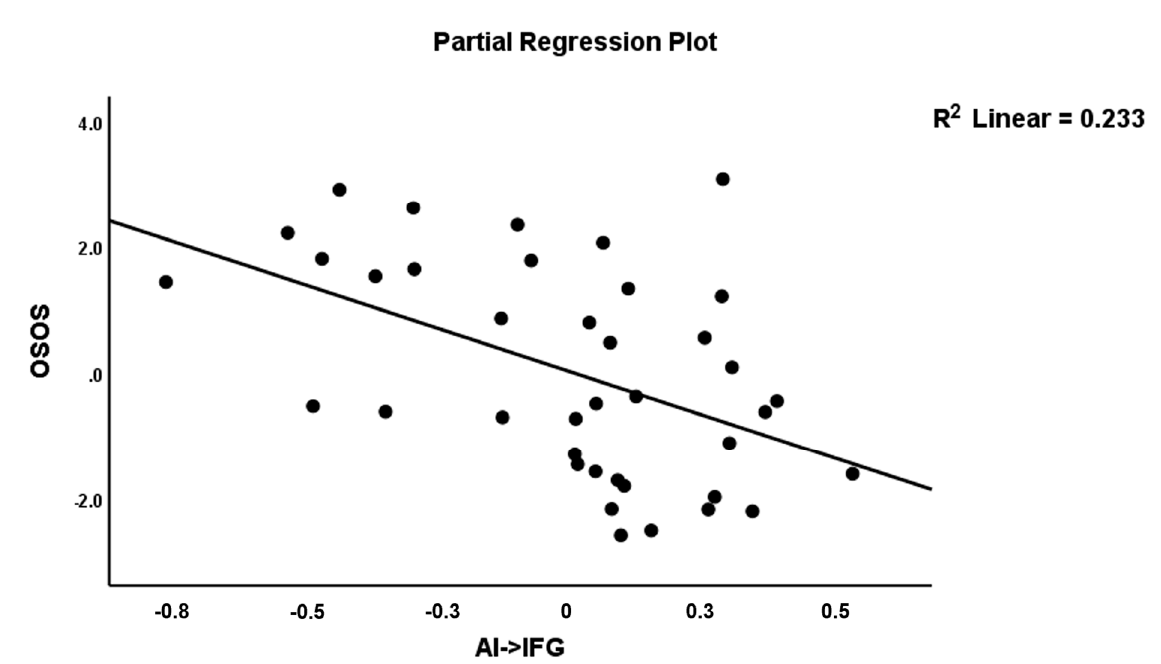
Figure 6. Partial regression plot of the OSOS score on the AI → IFG connection.